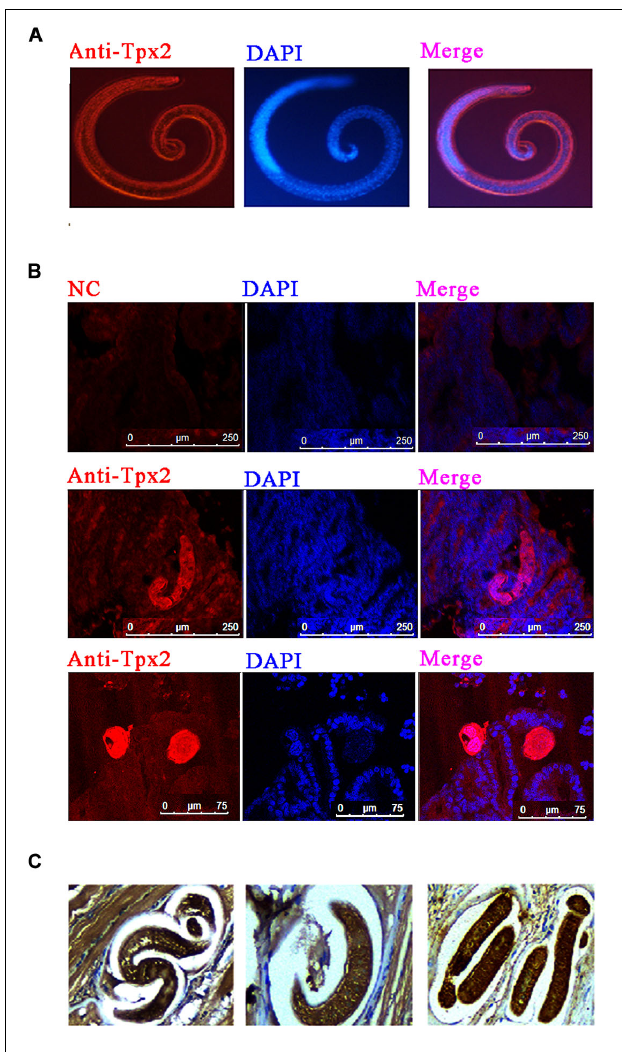
FIGURE 1 | Immunolocalization of TPX2 at different T. spiralis phases. (A) Immunofluorescence of TsTPX2 in muscle larvae (ML) at 35 dpi. (B) Immunofluorescence of TPX2 in adult worms at 3 days. (C) Immunohistochemistry of TsTPX2 in ML at 35